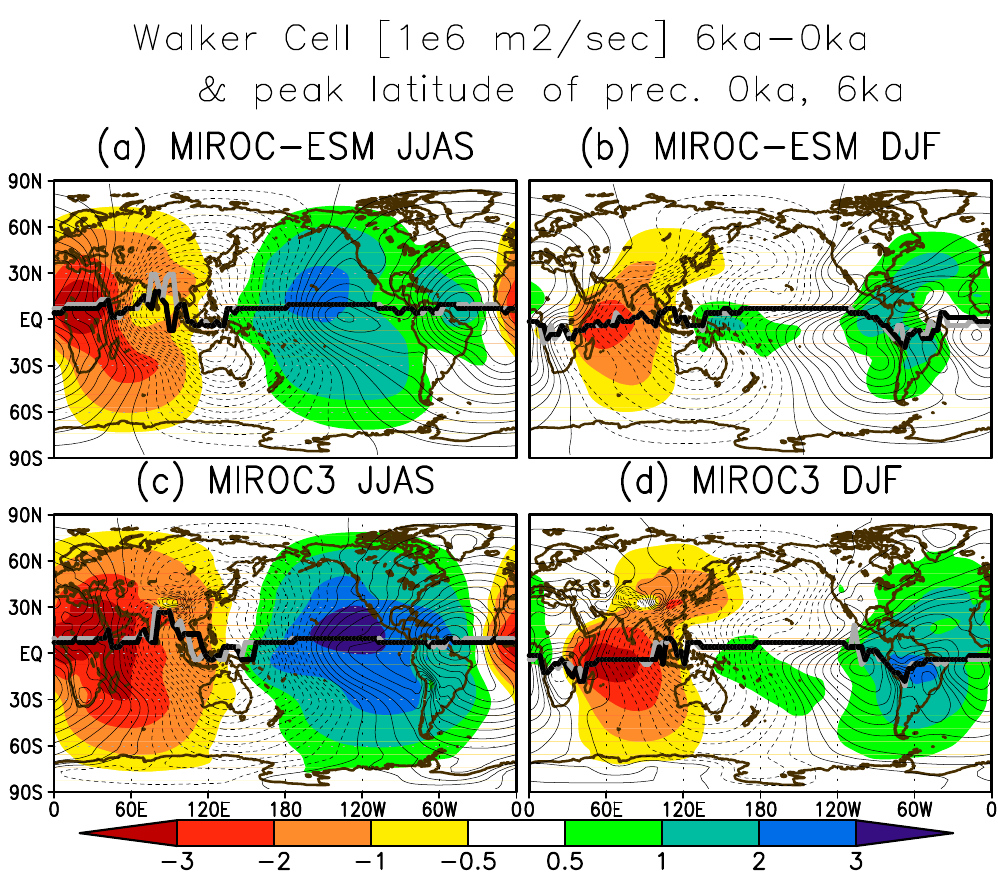
Fig. 4. Deviation from the zonal mean of the velocity potential at a pressure level of 200hPa [10 6 m 2 s − 1 ] and the latitudes of the peak of the precipitation. 6–0ka changes (shading) in JJAS (left panels) and DJF (right panels) are plotted for MIROC-ESM (upper panels) and MIROC3 (lower panels). The thin contour lines are 0ka values with intervals of 1 × 10 6 m 2 s − 1 . The thick black and grey lines correspond to the latitudes of peak precipitation between 30 ◦ S and 30 ◦ N at 0 and 6ka,